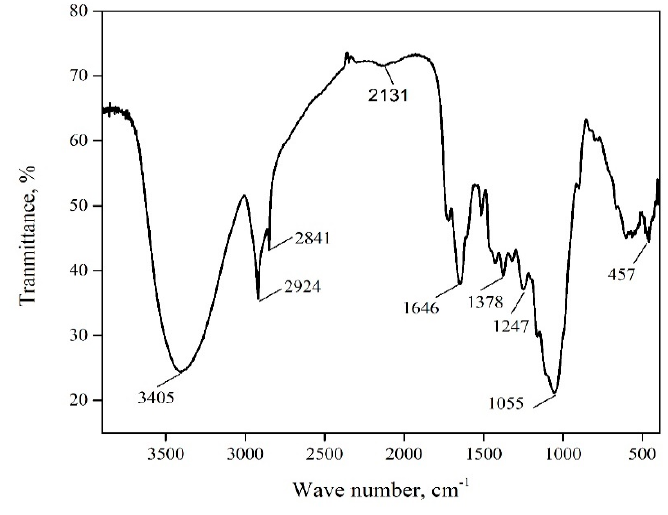
Figure 1. FTIR spectra of treated phragmites biomass.